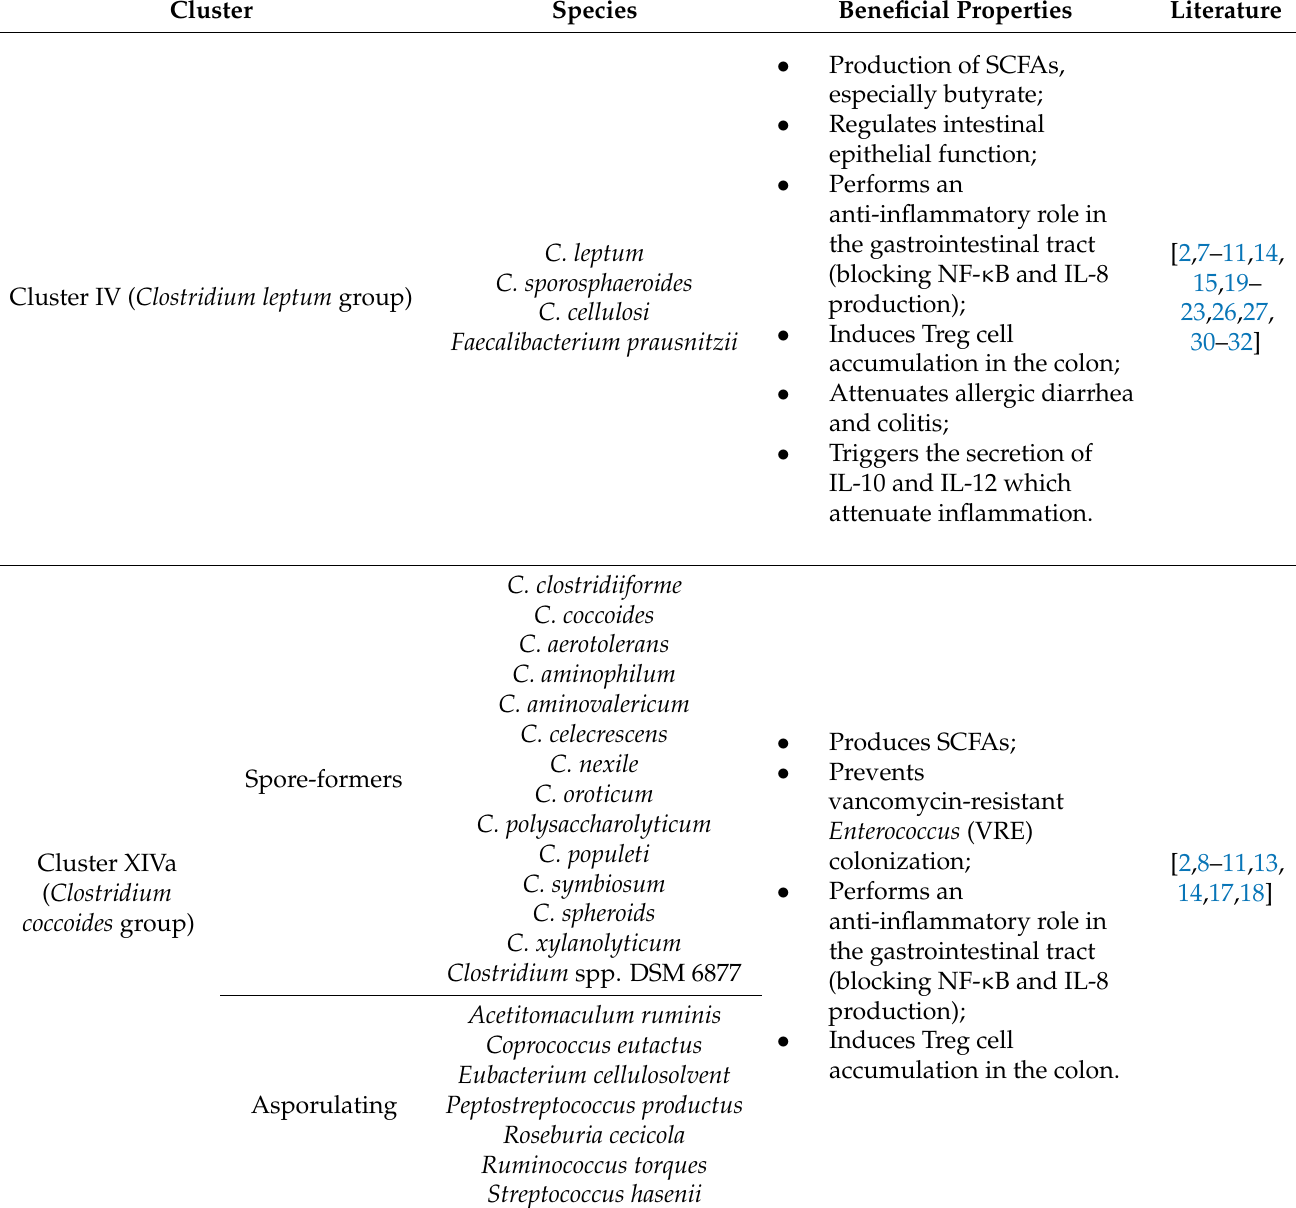
Table 1. Cluster IV ( Clostridium leptum group) and Cluster XIVa ( Clostridium coccoides group) probiotic